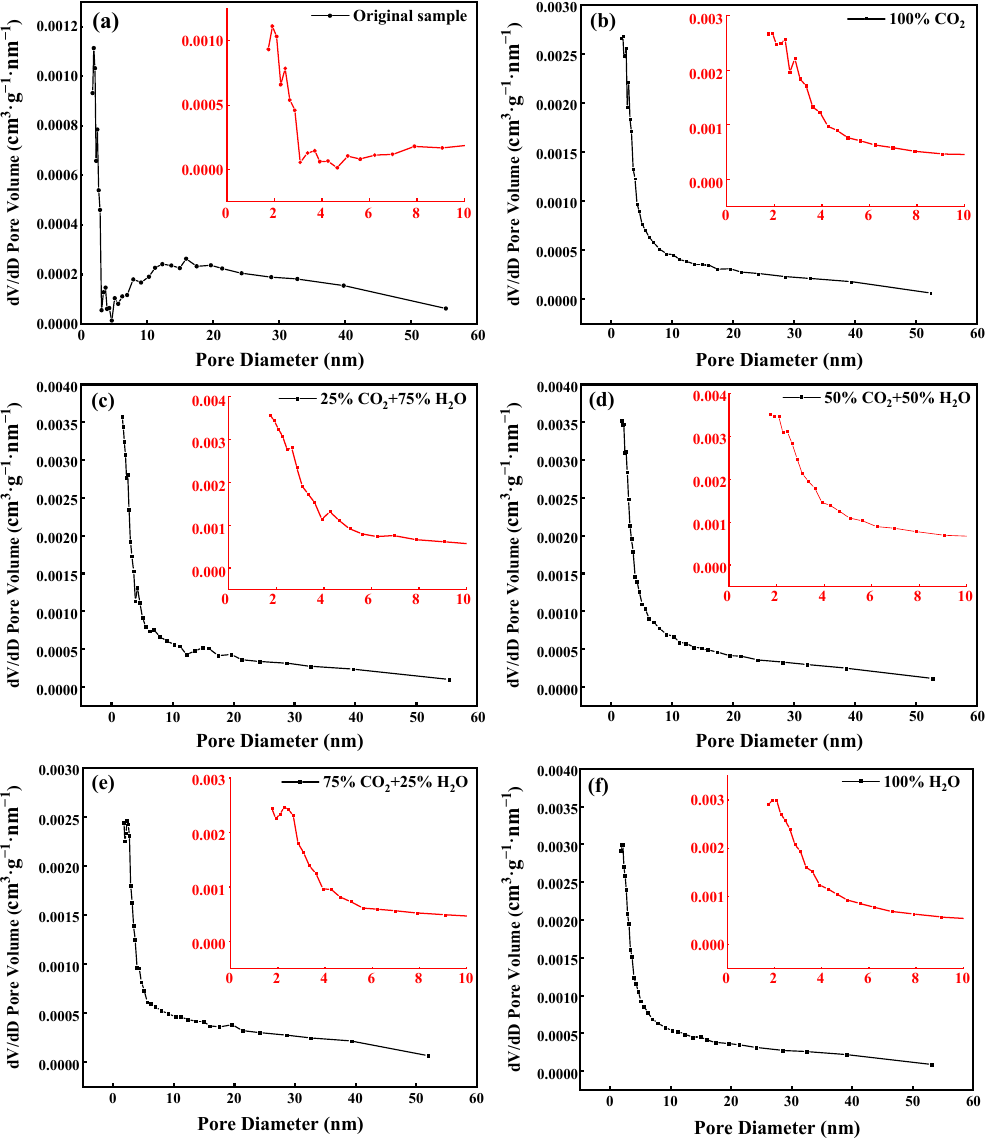
Figure 6. Pore-size distribution after the reaction of CO 2 and H 2 O in different proportions. ( a ) Original sample; ( b ) 100%CO 2 ; ( c ) 25%CO 2 + 75%H 2 O; ( d ) 50%CO 2 + 50%H 2 O; ( e ) 75%CO 2 + 25%H 2 O; ( f ) 100%H 2 O.